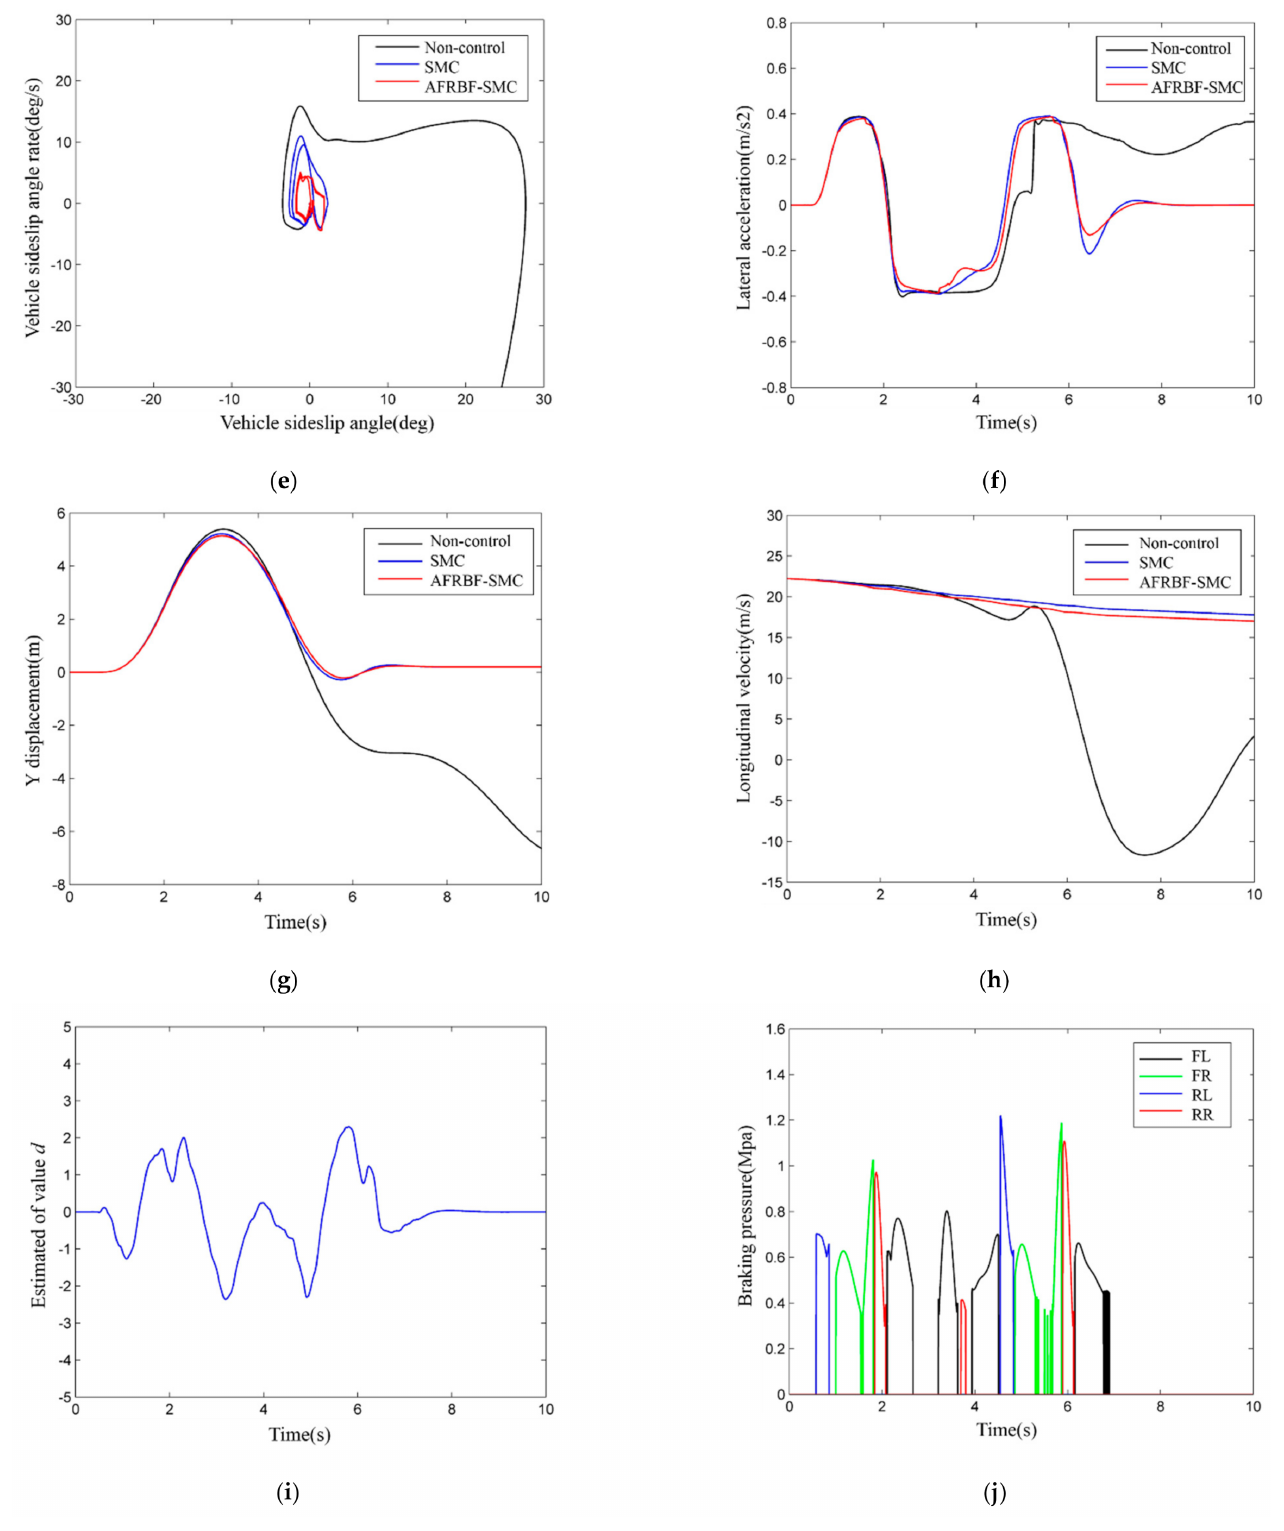
Figure 8. The simulation results of the front wheel sinusoidal steering test: ( a ) the comparison of estimated sideslip angle and real value; ( b ) the sideslip angle estimation error; ( c ) the vehicle yaw rates; ( d ) the vehicle sideslip angle; ( e ) the phase plane of the vehicle sideslip angle and the vehicle sideslip angle rate; ( f ) the vehicle lateral acceleration; ( g ) the vehicle lateral displacement; ( h ) the vehicle longitudinal velocity; ( i ) the estimated of value d ; ( j ) brake pressure of the braking wheels by AFRBF-SMC